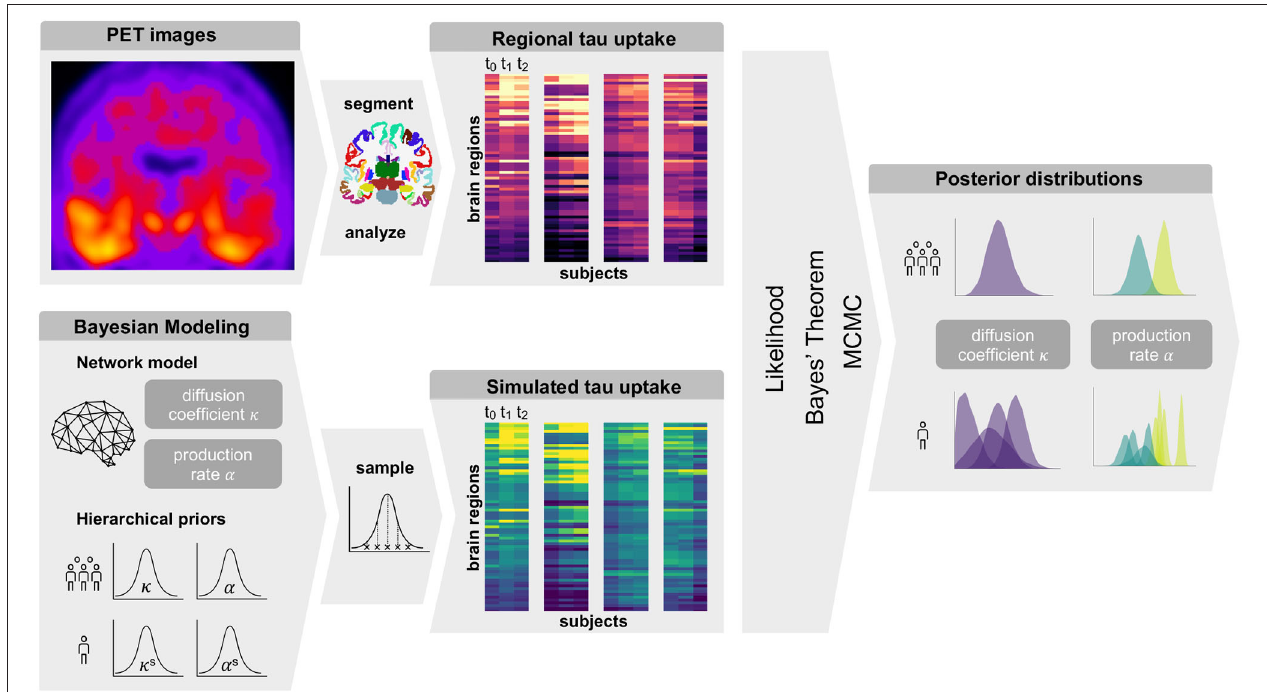
FIGURE 1 | Summary of Methods. Summary of our workflow including PET image analysis and Bayesian modeling to obtain personalized posterior distributions of two model parameters describing the tau pathology in the examined group of subjects.